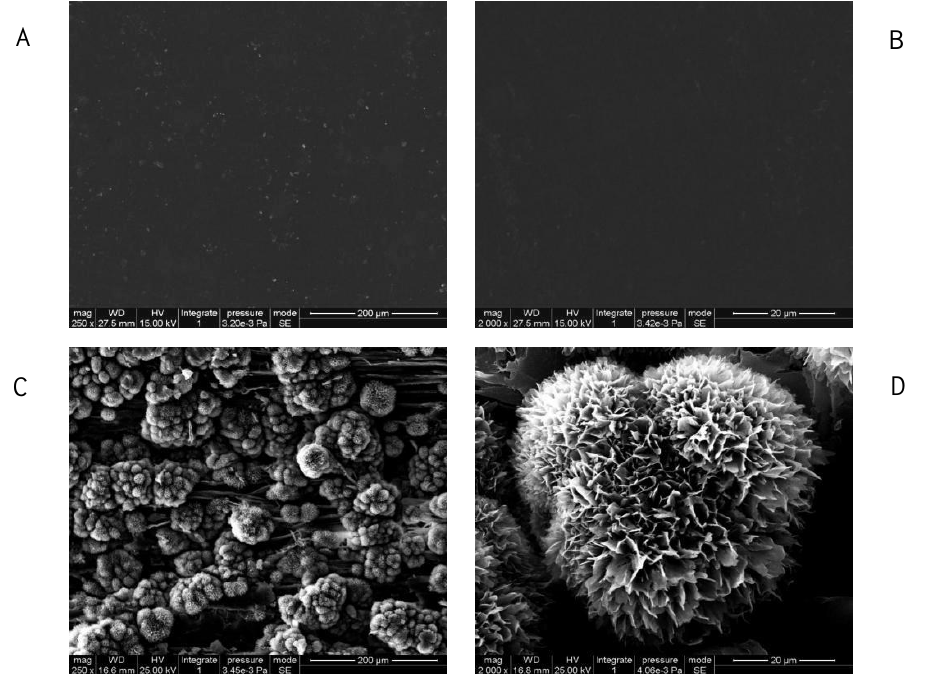
Figure 2. SEM images of WUV ( A : at 250 magnification; B : at 2000 magnification) and ZnSt2 / WUV ( C : at 250 magnification; D : at 2500 magnification) coatings.